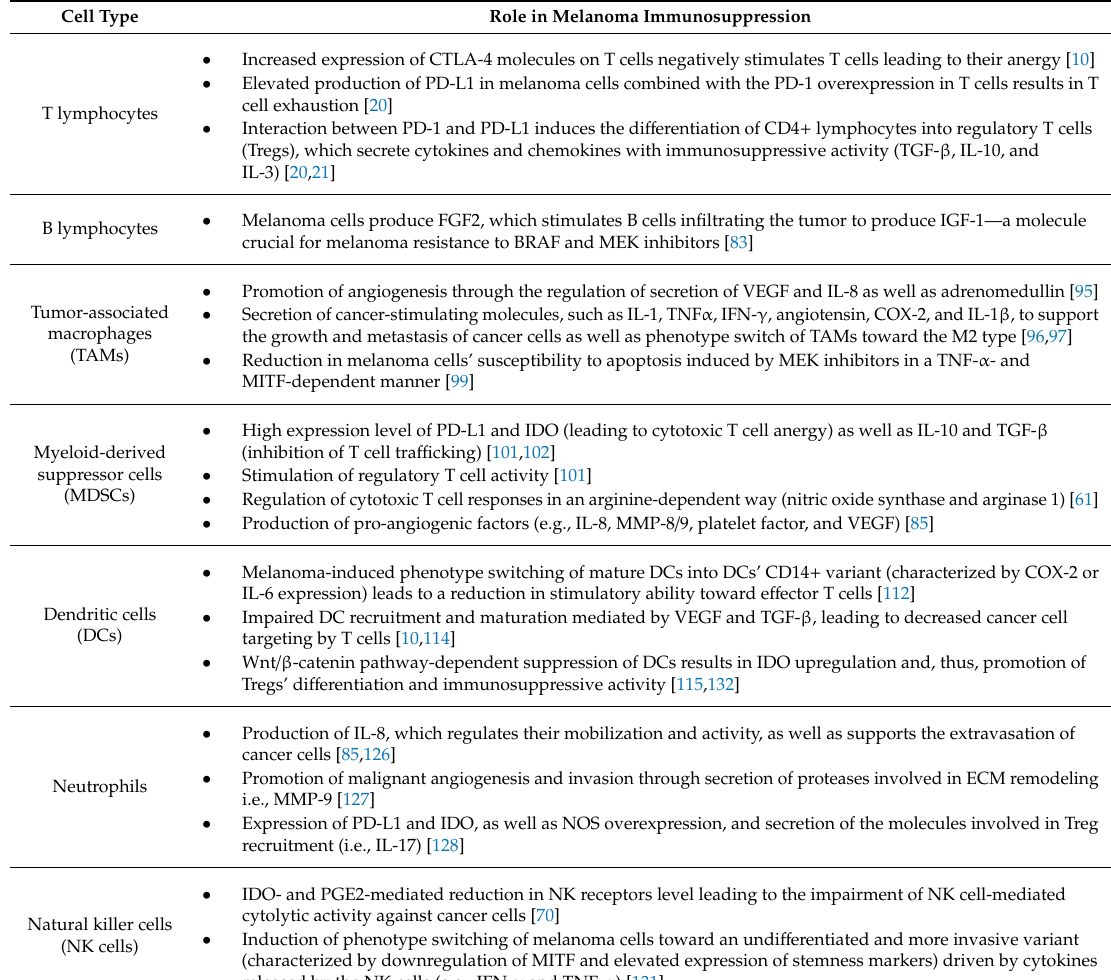
Table 5. Role of selected immune cell types in melanoma